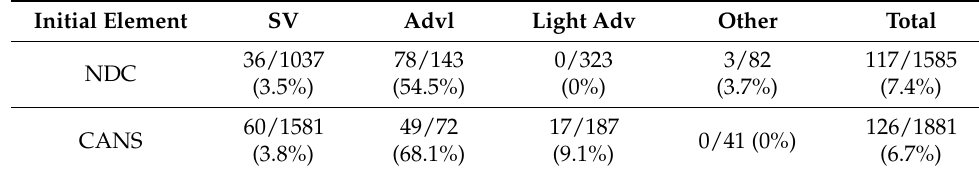
Table 3. Copy left dislocation in V2 clauses with different initial